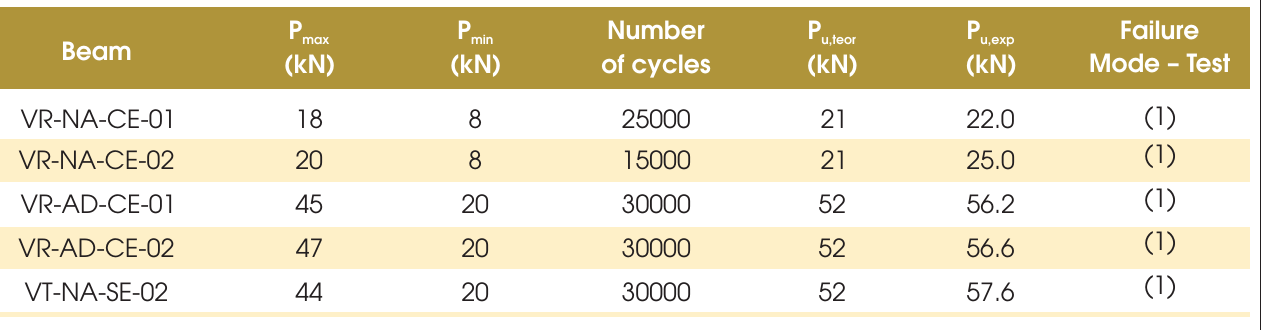
Table 2 – Test parameters of beams (groups I, II and III): cyclic and failure stages